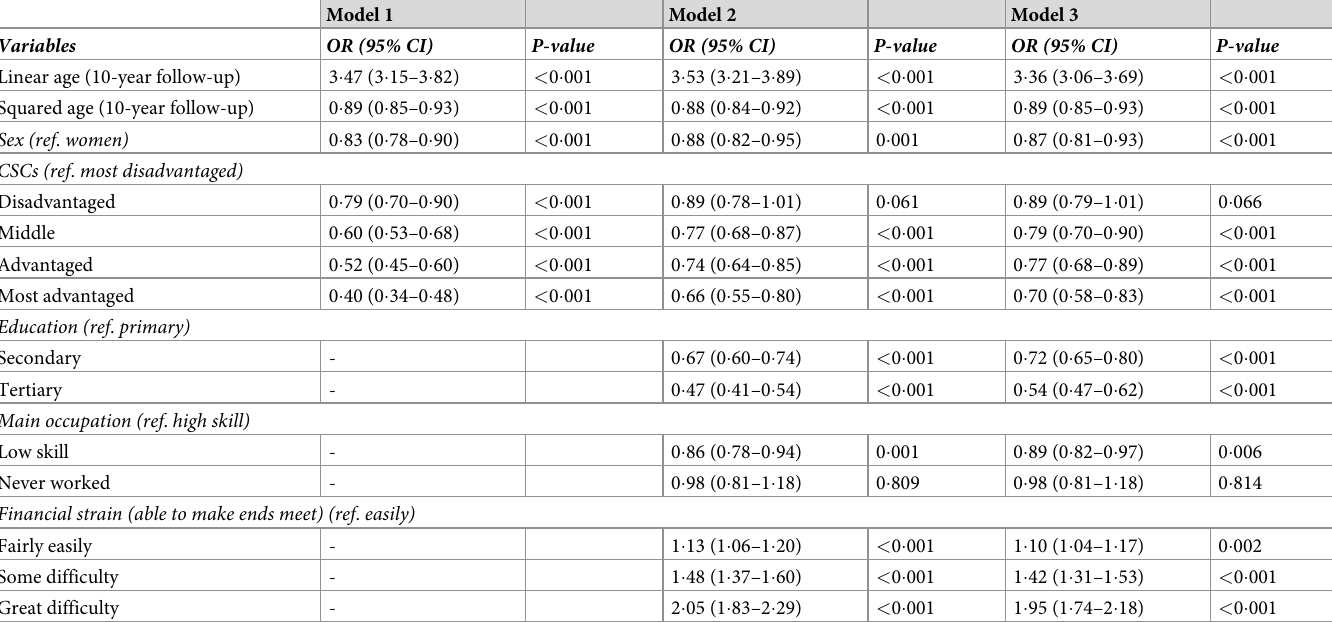
CSC categories, which shows that older adults with more advantaged CSCs had lower odds of multimorbidity than older adults with the most disadvantaged CSCs. The analyses stratified by sex (S7 Table in S1 File) showed an association between CSC cate- gories and odds of multimorbidity for both sexes (except for the disadvantaged CSC category for men, Model 1a). However, after adjusting for ACSs, CSCs did not remain associated with multimorbidity for men (Model 2a). However, for women, CSCs remained associated with multimorbidity (Models 1a, 2a and 3a). Table 2. Association of childhood socioeconomic conditions (CSCs) with odds of multimorbidity at age 73 years. (N =